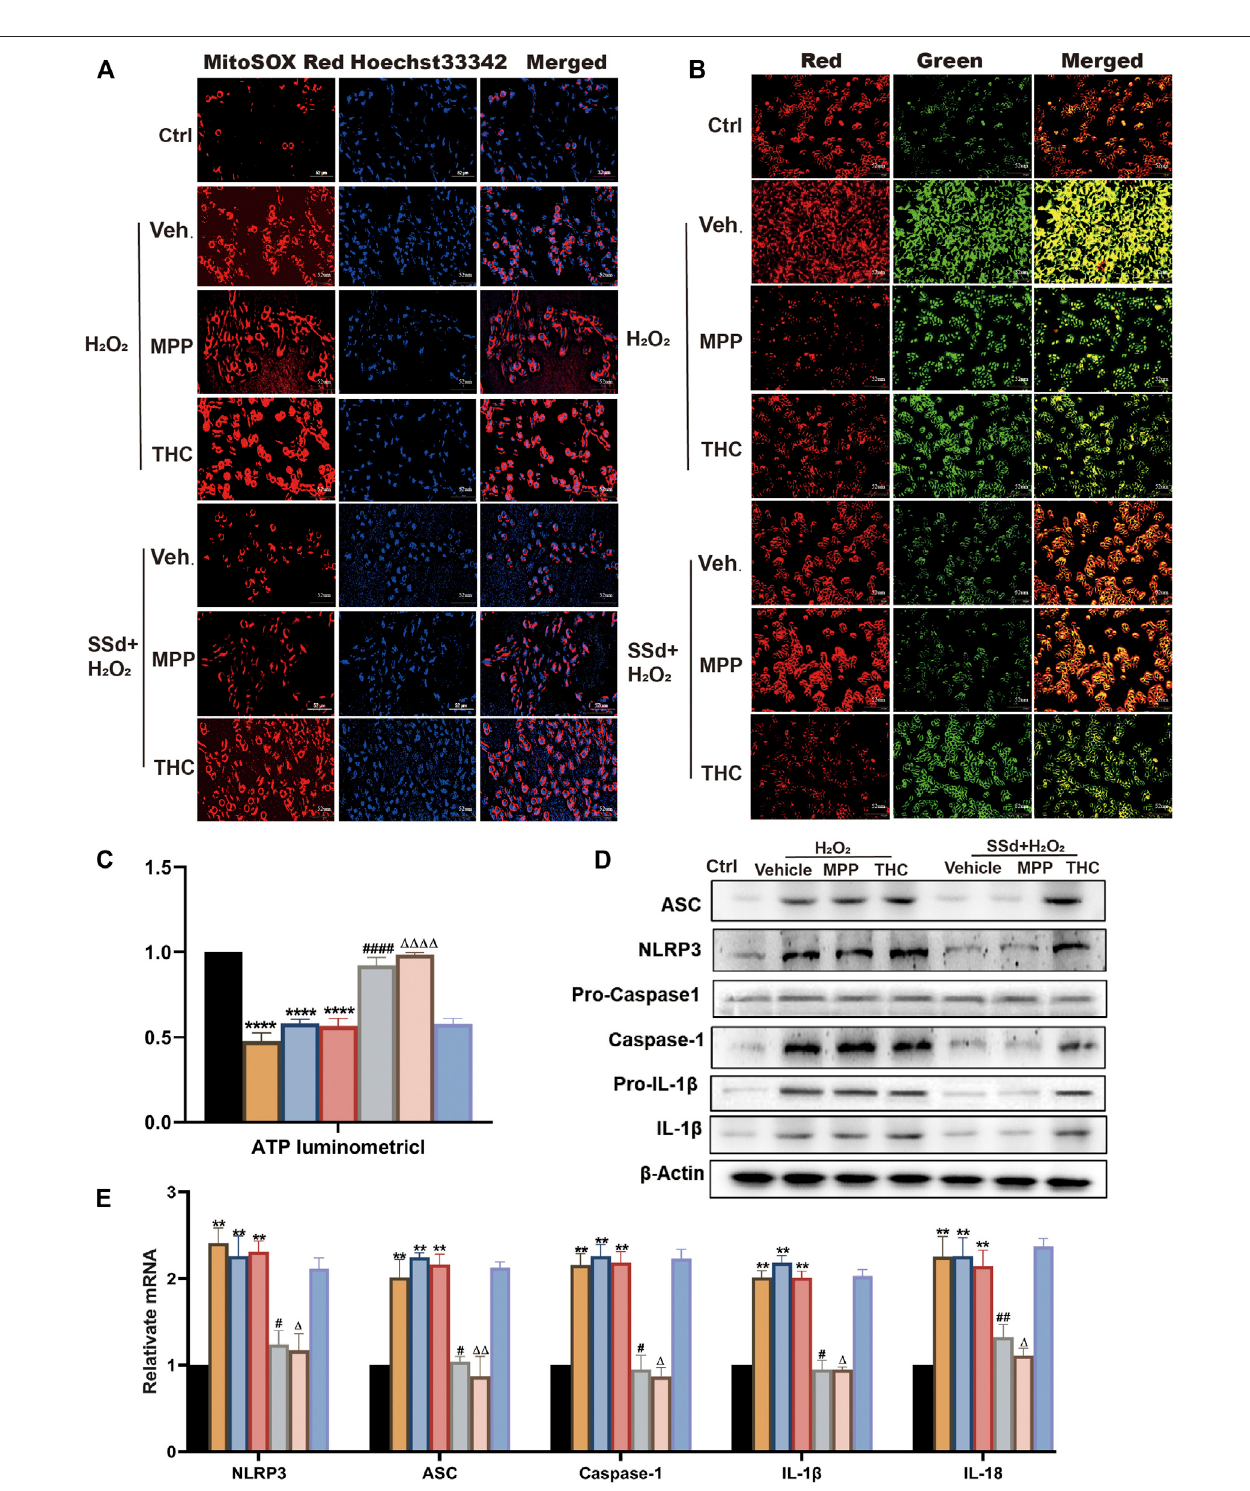
FIGURE7 | Speci fi cantagonistofER β , but not ER α , blocked theinhibitory effect ofSSd againstH 2 O 2 -induced mitochondrial dysfunction and NLRP3 activation in HSCs (A) . ROS production in HSCs in each group in estrogen receptor blockers alone or in combination with SSd treated group in HSCs (normal or activated state) (Scale bar, 52 μ m). (B) JC-1 membrane potential (Scale bar, 52 μ m). (C) ATP content, n = 6. (D,E) in fl ammasome complex expression was tested by PT-PCR and western blot experiment. in each group, n = 3. Data are expressed in mean ± SEM; ** p < 0.01, **** p < 0.0001, H 2 O 2 , H 2 O 2 +MPP, and H 2 O 2 +THC group versus control group; # p < 0.05, ## p < 0.01, #### p < 0.0001, SSd + H 2 O 2 group versus H 2 O 2 group; Δ P < 0.05, ΔΔ P < 0.01, ΔΔΔΔ P < 0.0001, MPP + SSd + H 2 O 2 group versus MPP + H 2 O 2